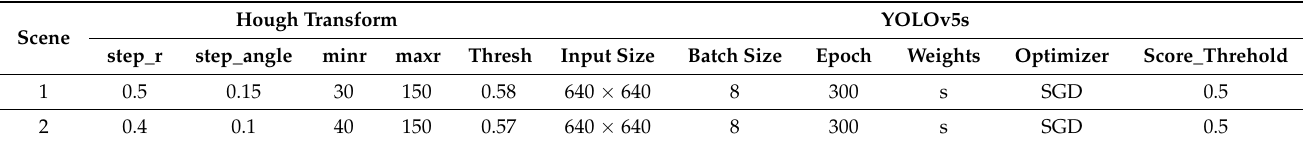
Table 2. Some initial training parameters of Hough transform and